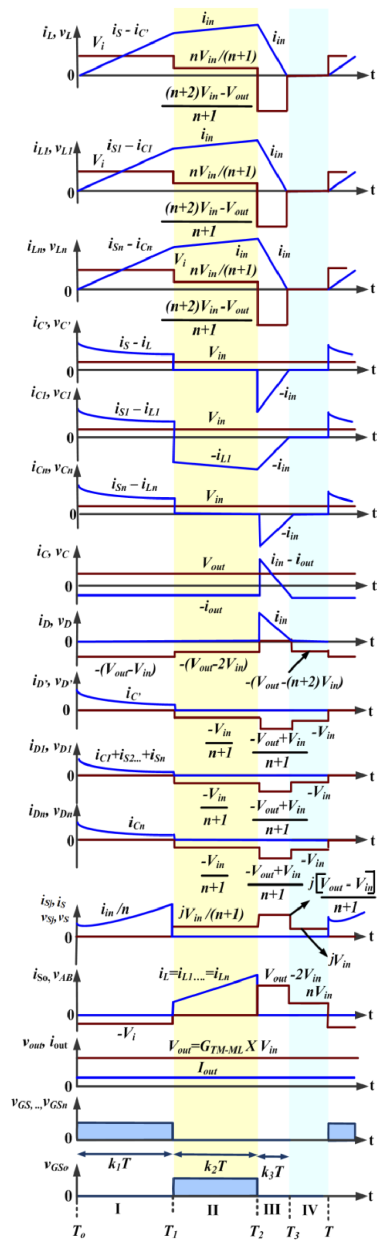
Figure 5. Voltage and current typical waveforms in